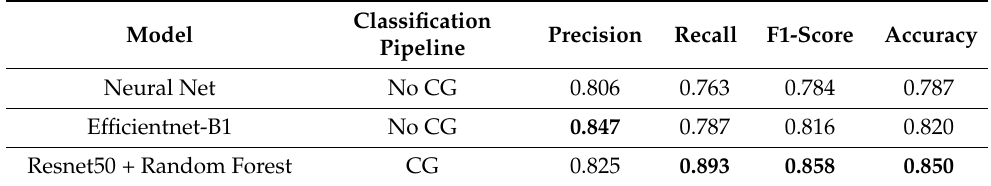
Table 5. The table presents the classification metrics for the pipelines with the highest recall across each of the different pipelines used for classification. The highest value for each metric is highlighted in bold. CG stands for cascade